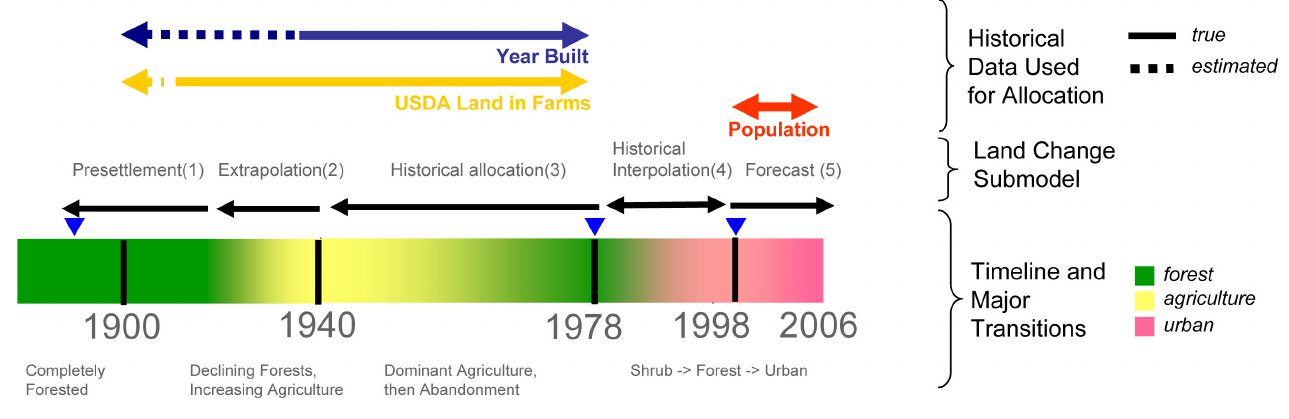
Fig. 2 . Illustration of the backcast land-change submodel used to develop the legacy